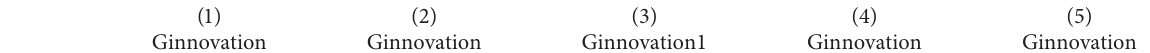
Table 4: Robustness